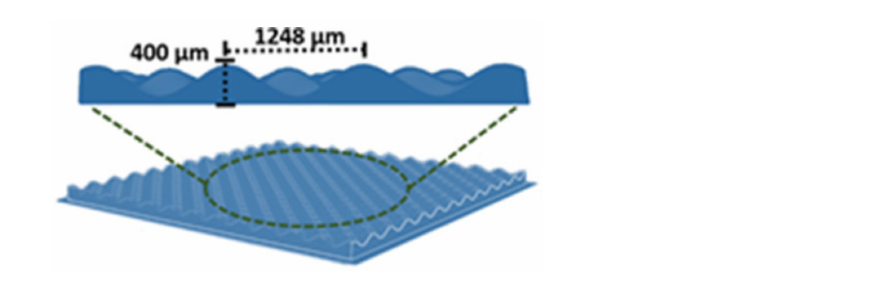
Figure 1. The patterned collector used to fabricate TCES loaded with bioactive compounds. Table 3. Polymer solutions and electrospinning process parameters used to fabricate